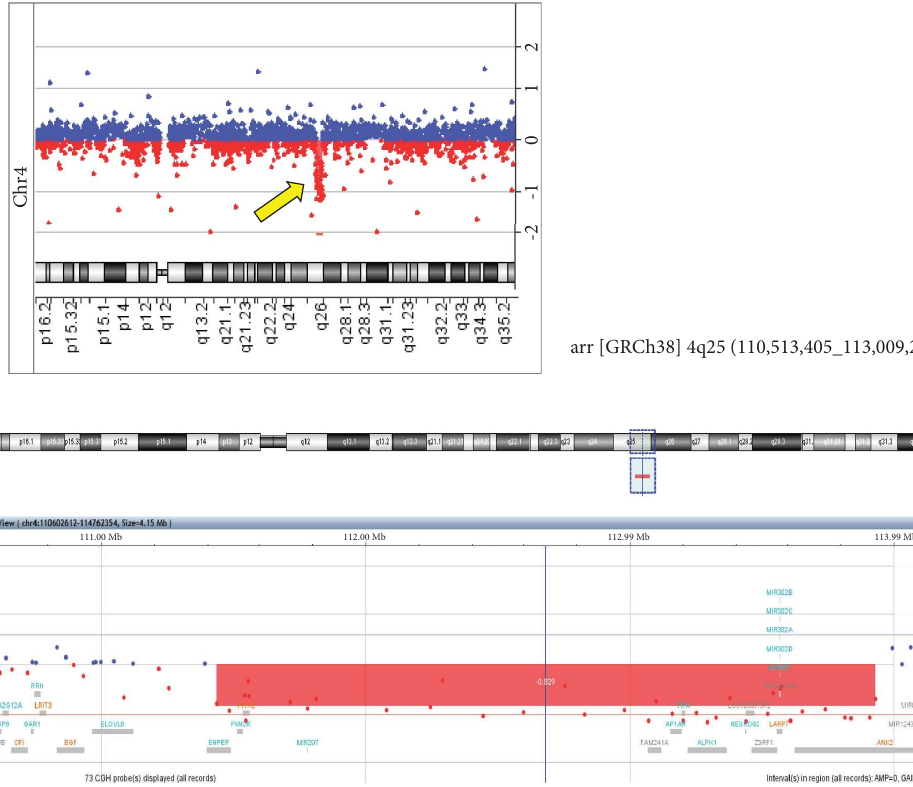
Figure 1: Array-based comparative genomic hybridization analysis revealed 2.5Mb deletion on chromosome 4q25, arr[GRCh38] 4q25(110,513,405_113,009,250)x1 encompassing ENPEP , PANCR , PITX2, MIR297 , FAM241A , AP1AR , TIFA, ALPK1, NEUROG2, LOC105377372 , ZGRF1 , LARP7 , MIR302CHG , MIR367 , MIR302D , MIR302A , MIR302C , MIR302B , and ANK2.